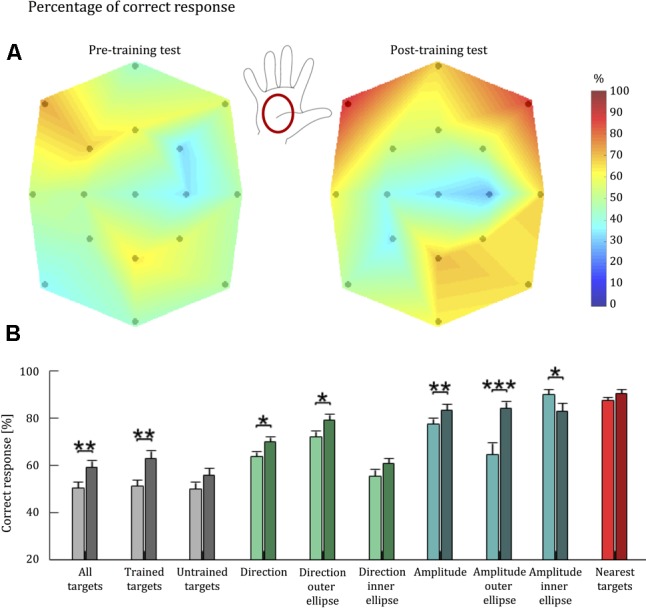
Tactile acuity of healthy individuals before and after training with the Tactile-STAR. (A) A colormap of the percentage correct responses for brush stimuli as a function of palm location. 100% corresponds to red, while 0% corresponds to dark blue. The black dots indicate the coordinates of the targets reached by the stimulator device, which started moving from the central target. The colors associated to intermediate coordinates were obtained by linear interpolation from the test points. Between the two colormaps, the illustration of the right hand shows where the stimuli were applied. The central position of the map corresponds to the center of the palm. (B) Bars represent population average percentage correct responses for each parameter: correct target (gray), correct direction (green), correct amplitude (blue), and nearest targets (red). Light colors are associated with performance before training; dark colors are associated with performance after training. Error bars indicate the standard error of the mean. ∗p < 0.05, ∗∗p < 0.01, ∗∗∗p < 0.001.